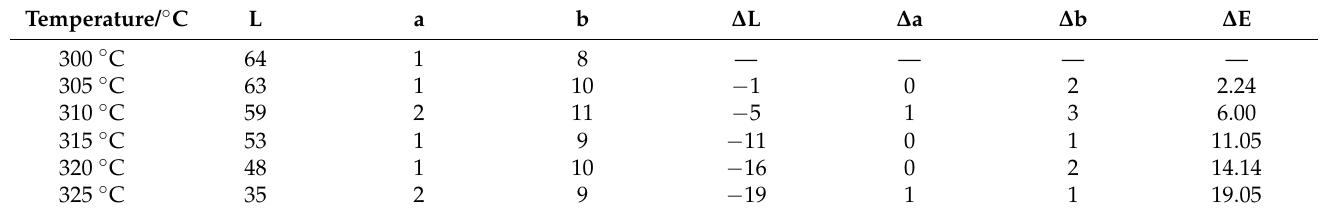
Table 3. Surface colour extraction of glass fibre reinforced polyphenylene sulphide composites at different moulding